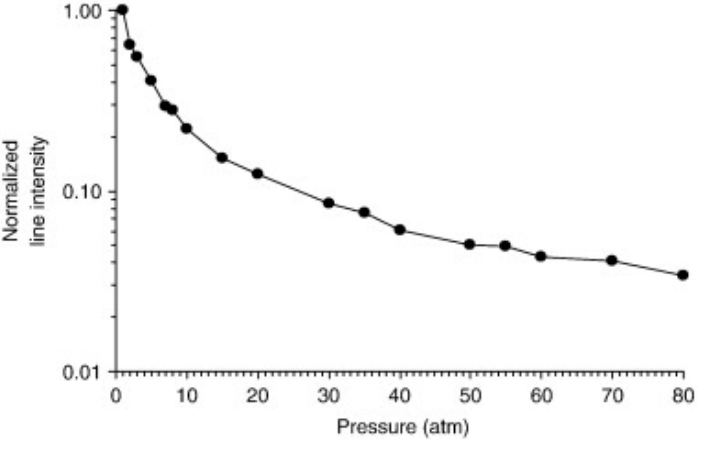
Figure 8. LIBS spectra intensity of C versus an increasing N reference